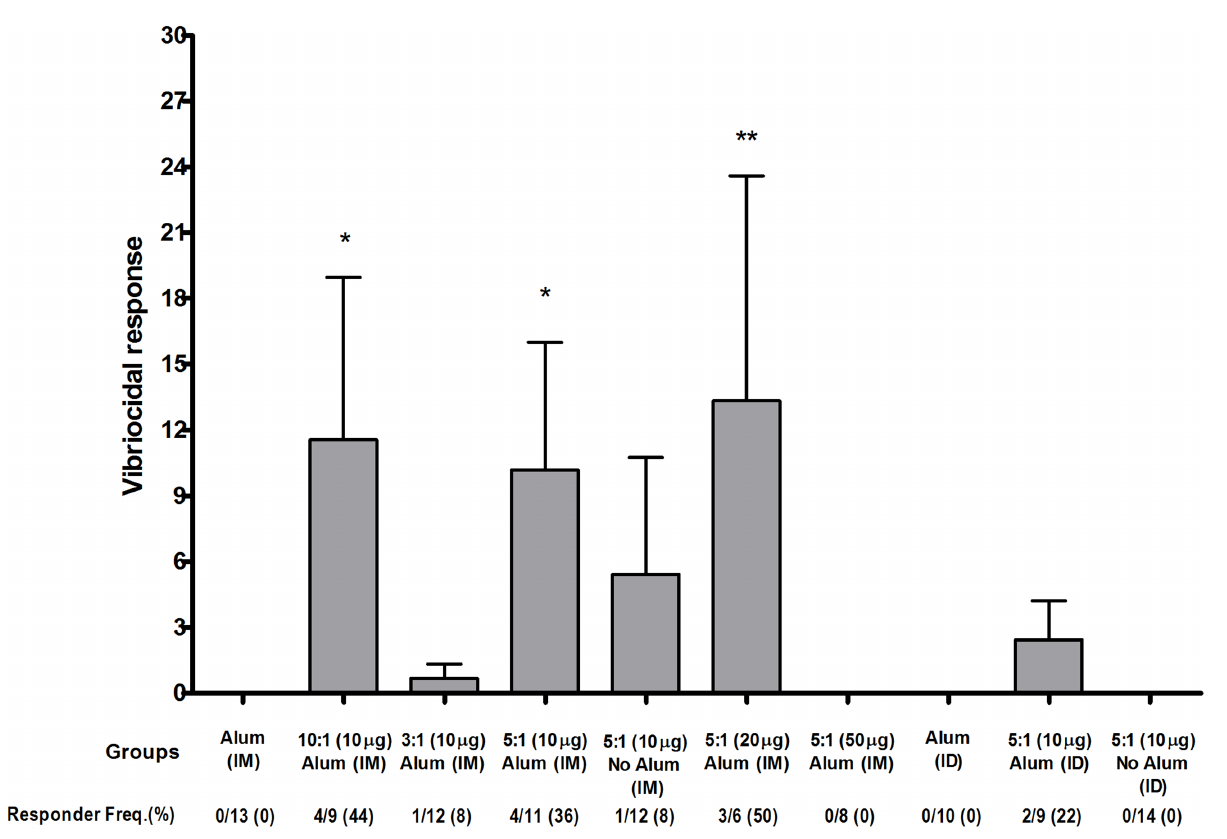
Fig 5. Vibriocidal responses in vaccine cohorts. An asterisk denotes a statistically significant difference ( P < 0.05) in the mean response from the group immunized with only